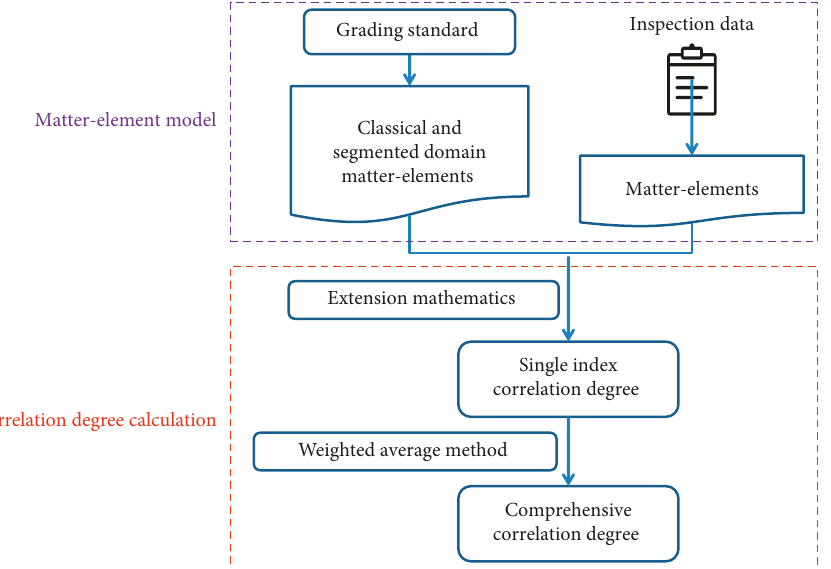
Figure 3: Matter-element extension